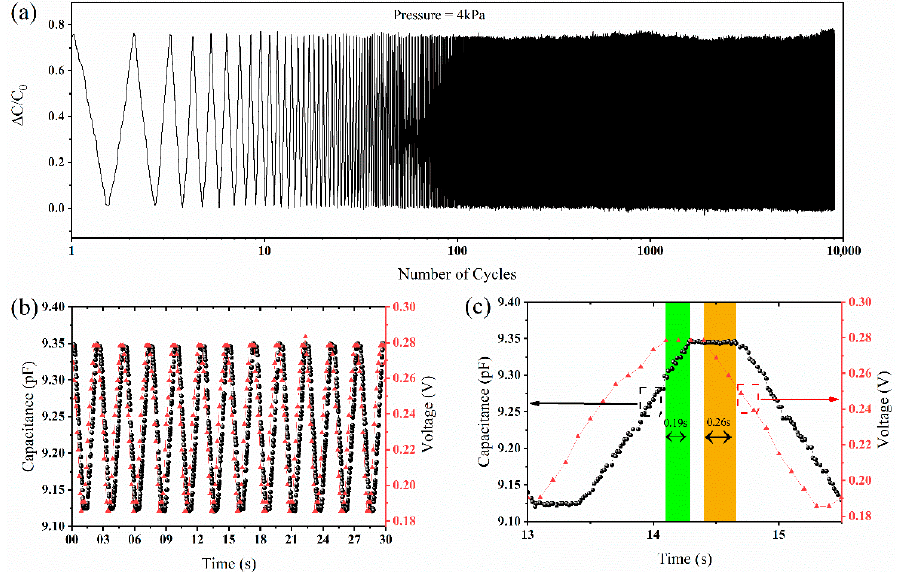
Figure 5. ( a ) Stability test of the MWCNT-PDMS-based pressure sensor showing stable performance for 9000 cycles. ( b ) Comparison of sensor performance between the CPS and a commercial sensor.